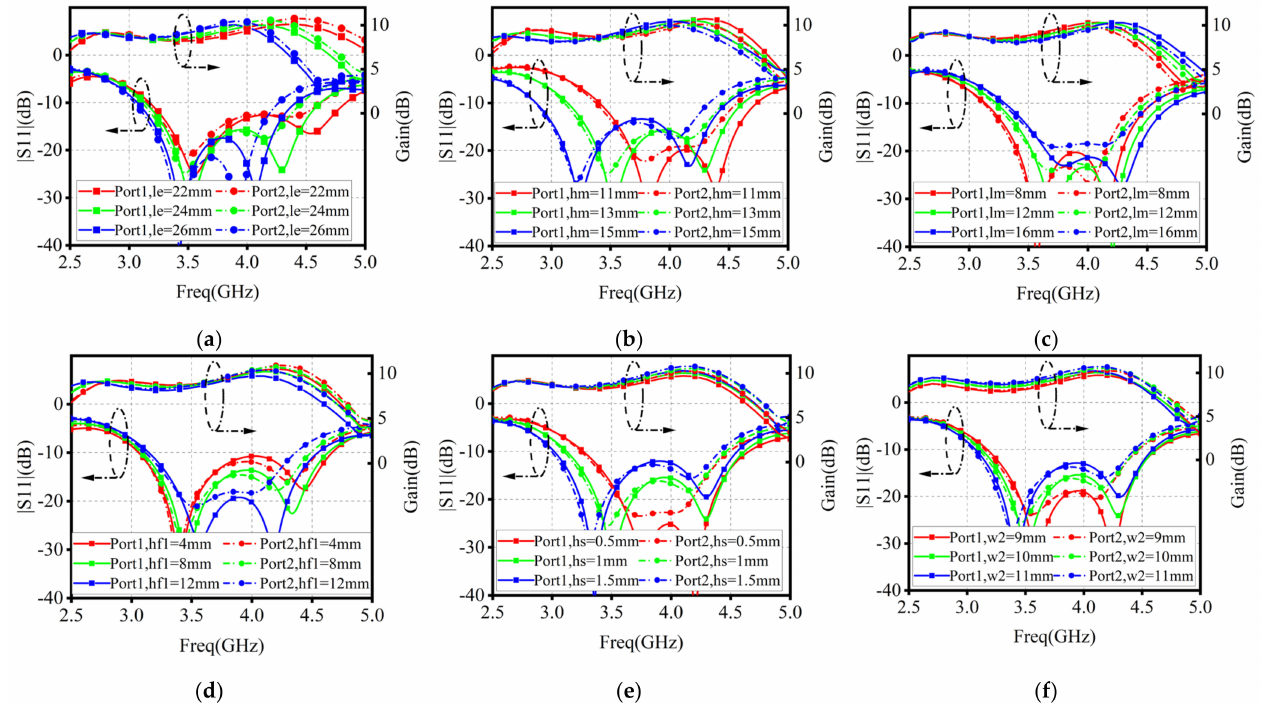
Figure 5. Parametric analyses of different parameter dimensions: ( a ) length of the electric dipole; ( b ) height of the magnetic dipole; ( c ) length of the magnetic dipole; ( d ) height of the feeding structure; ( e ) height of the meandering slots; ( f ) length of the meandering